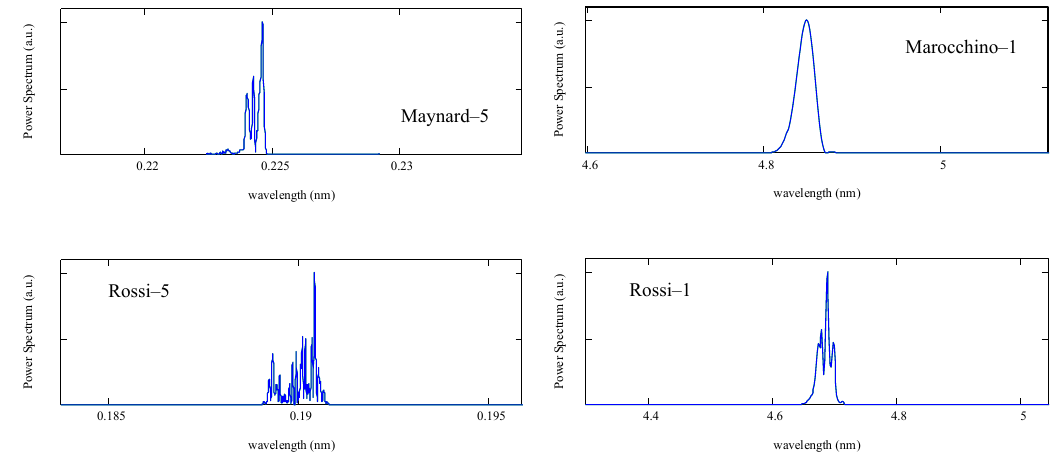
Figure 5. Wavelength spectra at saturation of the specified beam distributions, for the fundamental harmonic.